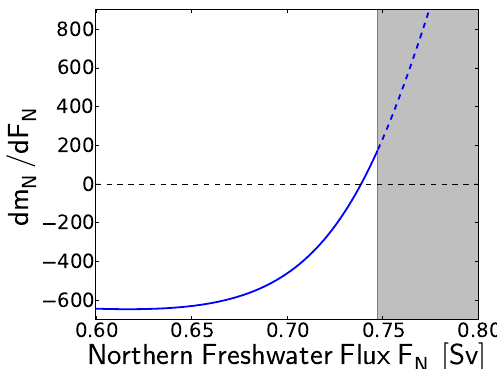
Figure 6. The derivative of the northern sinking with respect to freshwater forcing in the full case. The derivative is positive be- fore the circulation collapses (white area). This behaviour is caused by a change in the Southern Ocean temperature from T S = 7 ◦ C to T S = 5 ◦